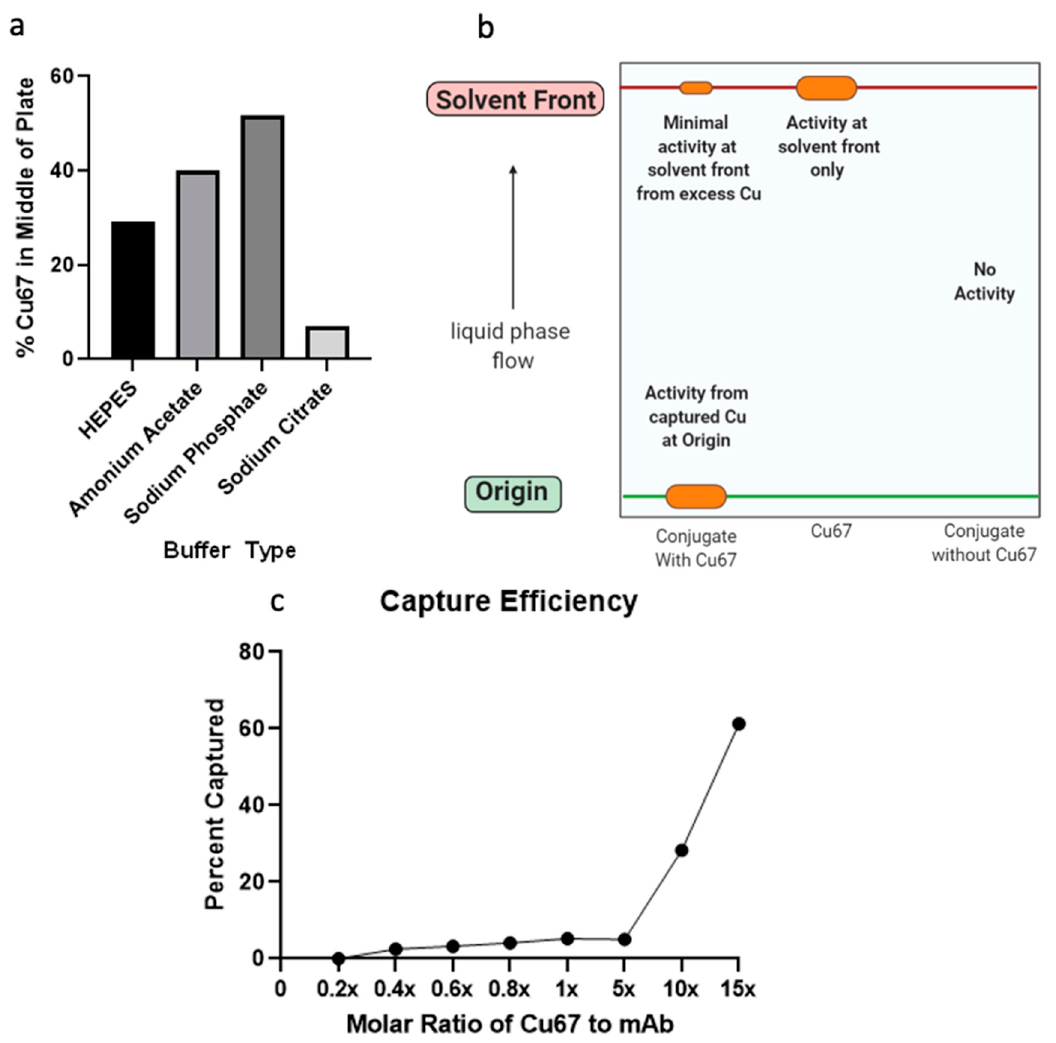
Figure 4. Copper Capture and Stability of the anti-OSMR RIT. ( a ) Results of testing multiple buffer types for best definition achieved on TLC plate. Best definition was measured as the conditions with the least amount of radioactivity in the middle of the TLC plate. ( b ) Schematic for how TLC tests were performed. ( c ) Results of copper capture rate experiments, capture efficiency was measured at varying molar ratios of 67 Cu to OSMR mAb.